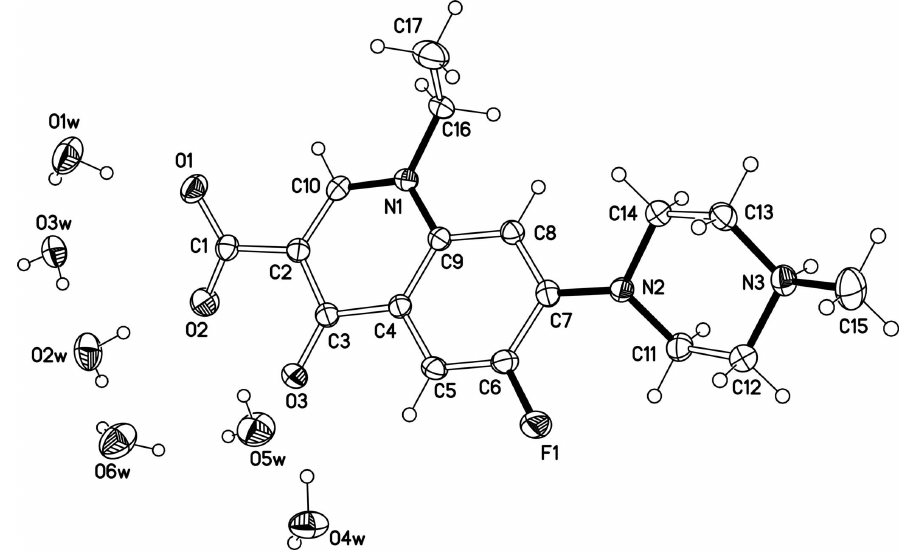
Figure 1 The asymmetric unit of (I), showing 50% displacement ellipsoids. 1-Ethyl-6-fluoro-7-(4-methylpiperazin-4-ium-1-yl)-4-oxo-1,4-dihydroquinoline- 3-carboxylate